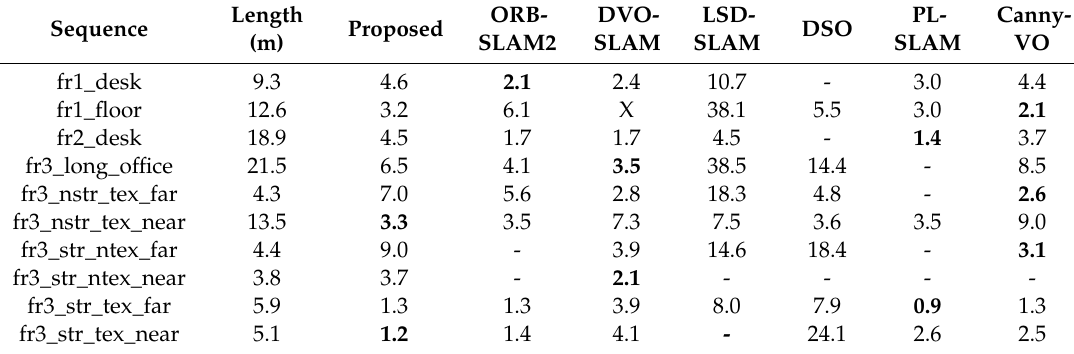
Table 1. Comparison of ATE RMSE (cm) on TUM RGB-D